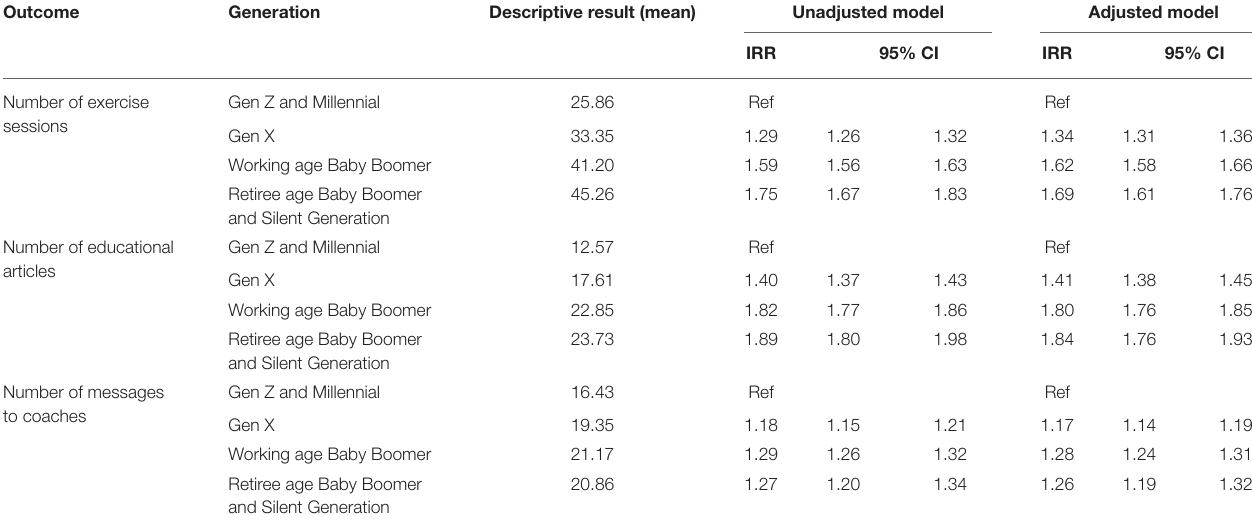
TABLE 3 | Program engagement outcomes, by generation.